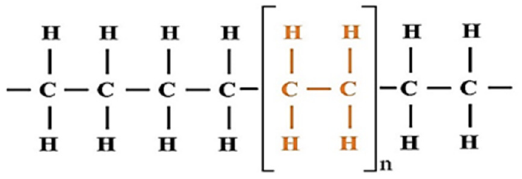
Figure 4. Chemical structure of polyethylene [46].